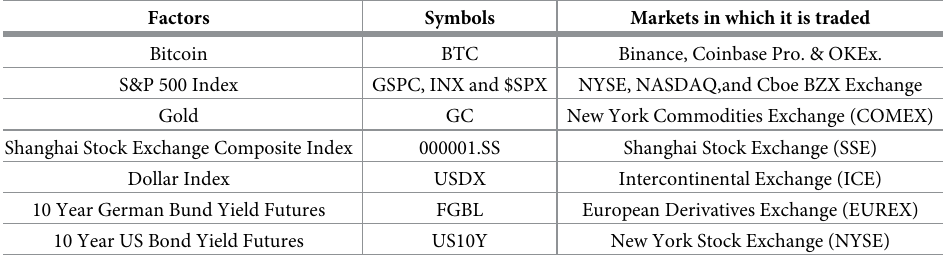
Table 1. Symbols of the financial instruments along with the markets they are traded in are shown. Factors Symbols Markets in which it is traded Bitcoin BTC Binance, Coinbase Pro. &